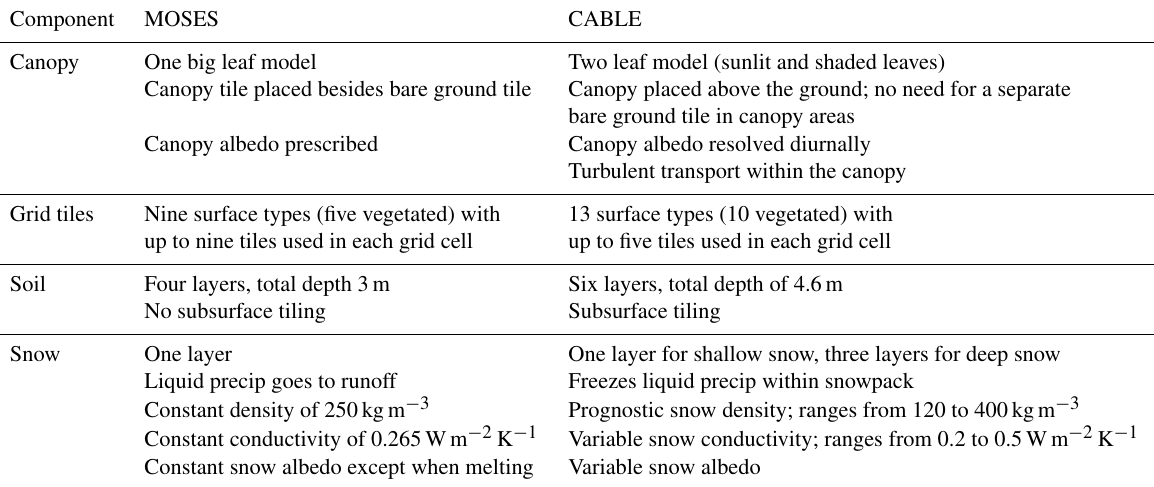
Table 1. The list of major differences in structure and canopy, soil, and snow components for MOSES as configured in ACCESS1.0 and CABLE as configured in ACCESS1.1.